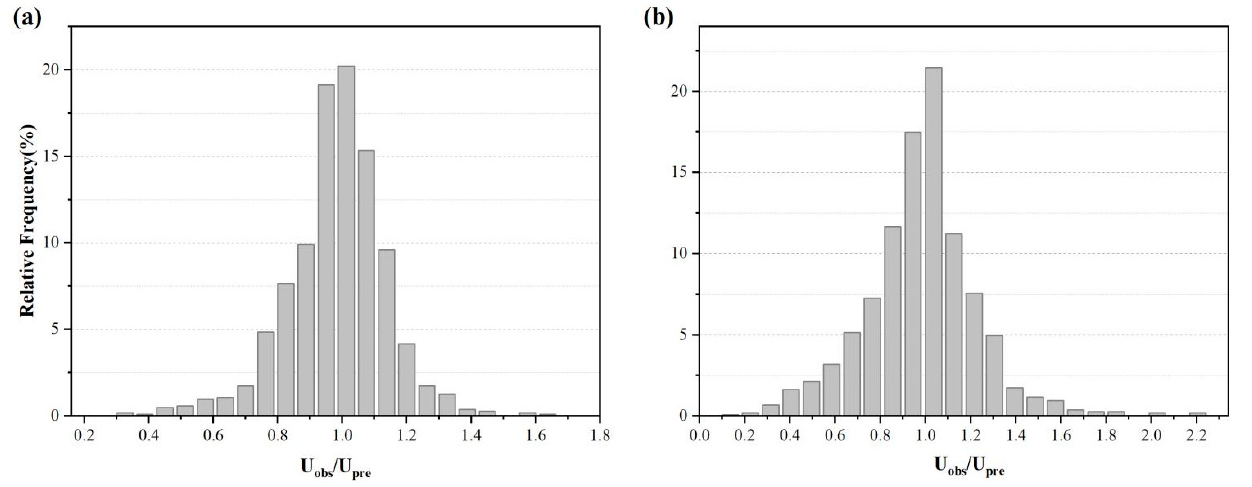
Figure 9. Relative frequencies of observed and predicted compressive strength ratios CS obe /CS pre : ( a ) of dataset 1 and ( b ) of dataset 2.